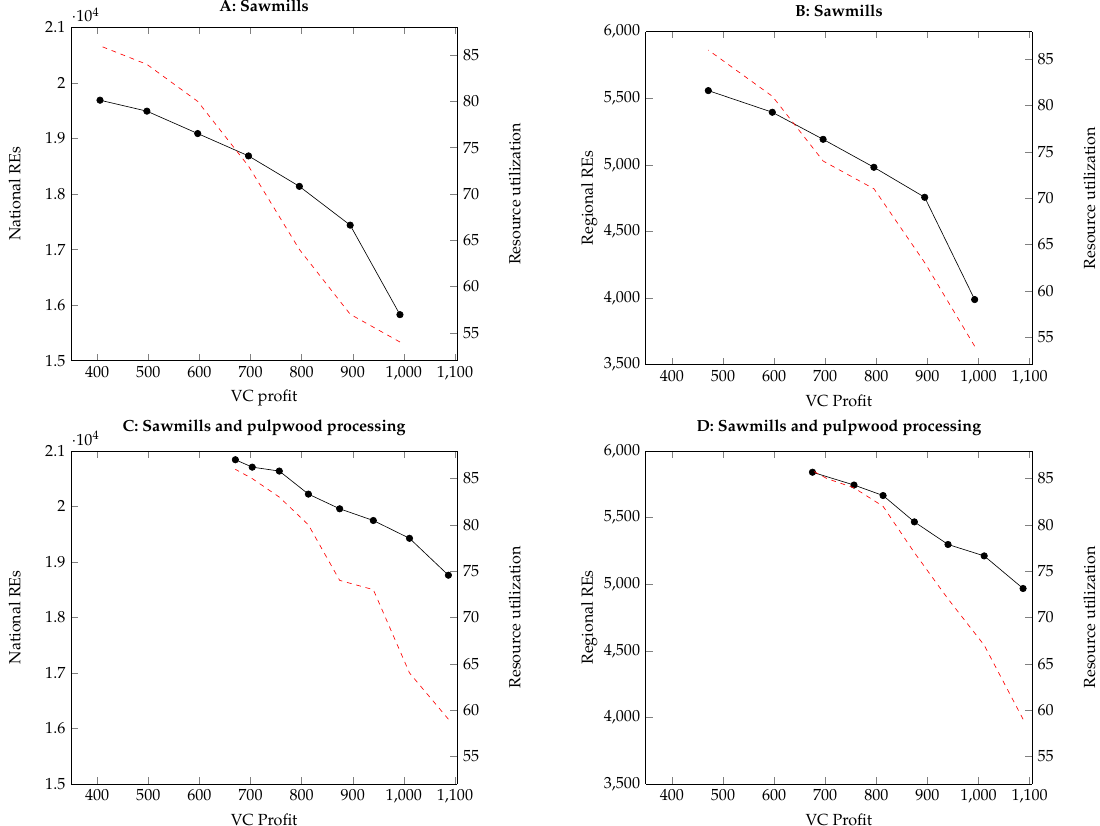
Figure 4. Trade-off between VC profit and REs (black line, left axis) in million USD with national ( A and C ) and regional focus ( B and D ), respectively. Corresponding regional resource utilization in percent shown as red dotted line (right axis). A and B show investment options in sawmills only; C and D show investment options in both sawmills and pulpwood processing